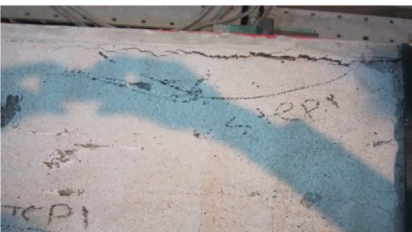
Figure 17: The progress of longitudinal cracks between the cold-rolled galvanized sheets and the foamed concrete.